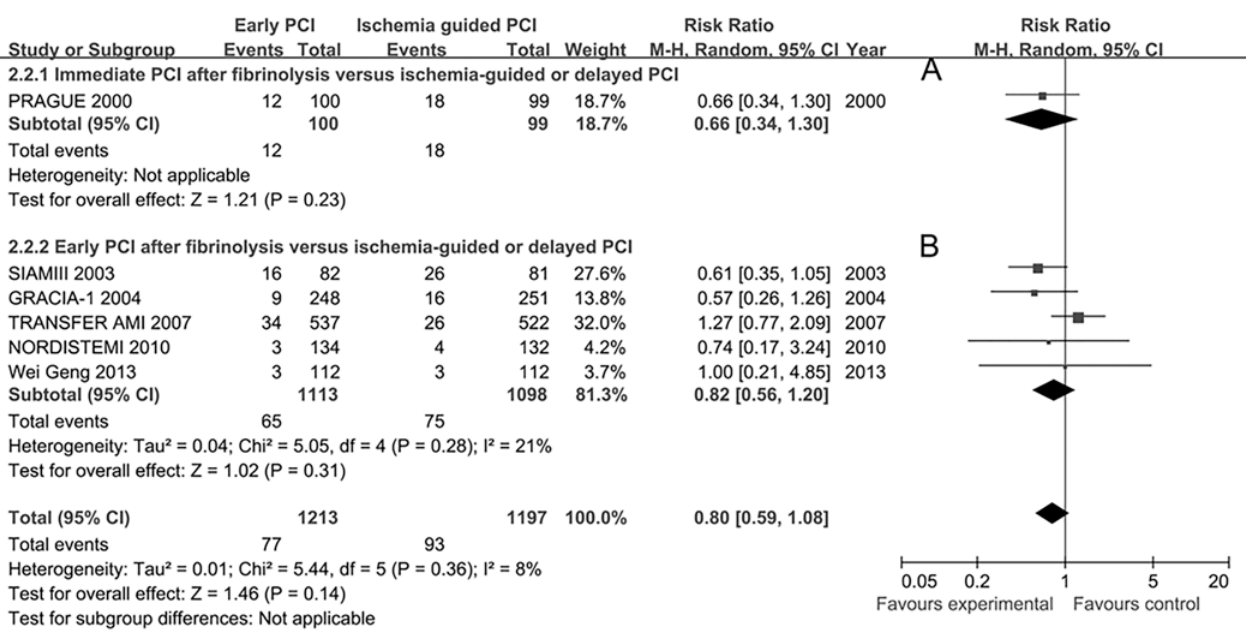
Fig 6. Long-term mortality for immediate or early percutaneous coronary intervention (PCI) after fibrinolysis versus ischemia-guided or delayed PCI.